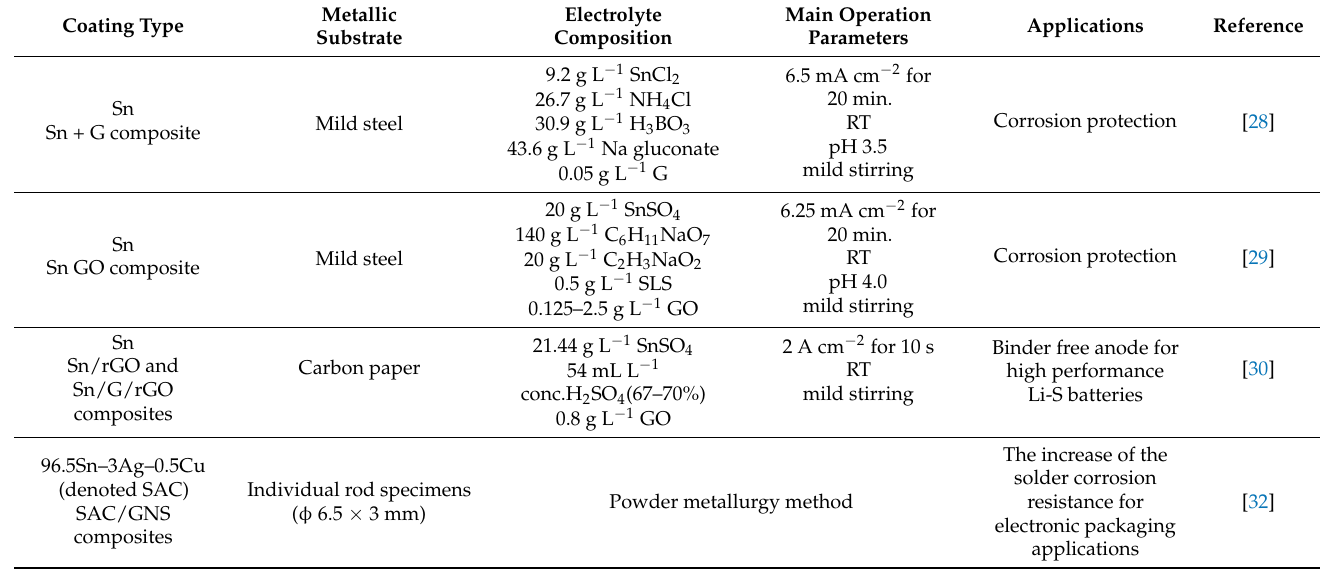
Table 1. Results from previous reports regarding the electrodeposition of Sn and Sn alloy composites with graphene related materials involving aqueous